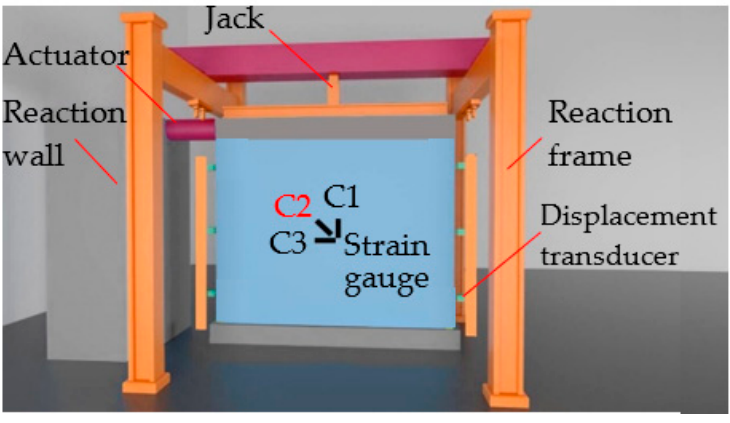
Figure 4. Test setup.